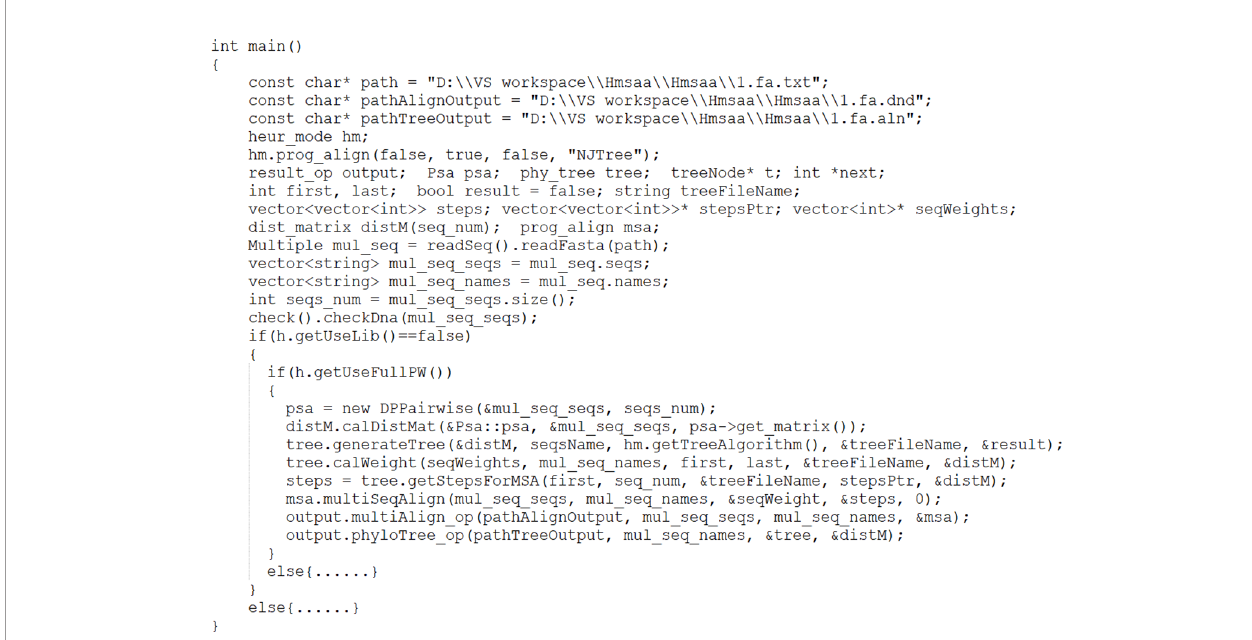
FIGURE 6 | C++ assembly process of